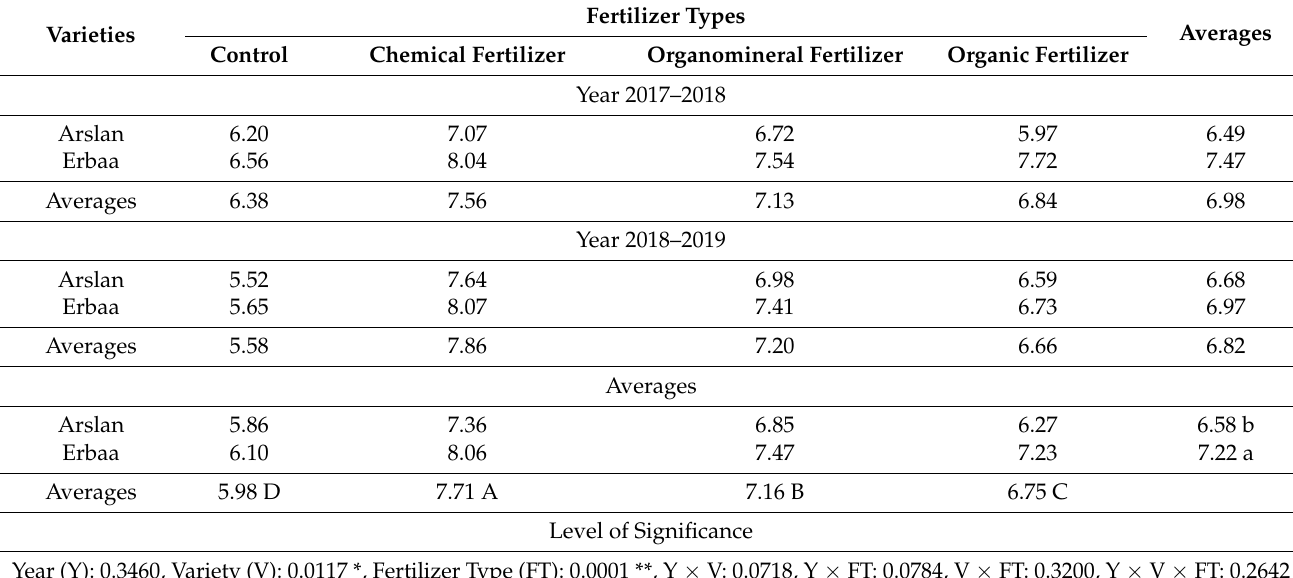
Table 4. The effect of fertilizer types on the number of branches in coriander varieties (pieces) 1 .